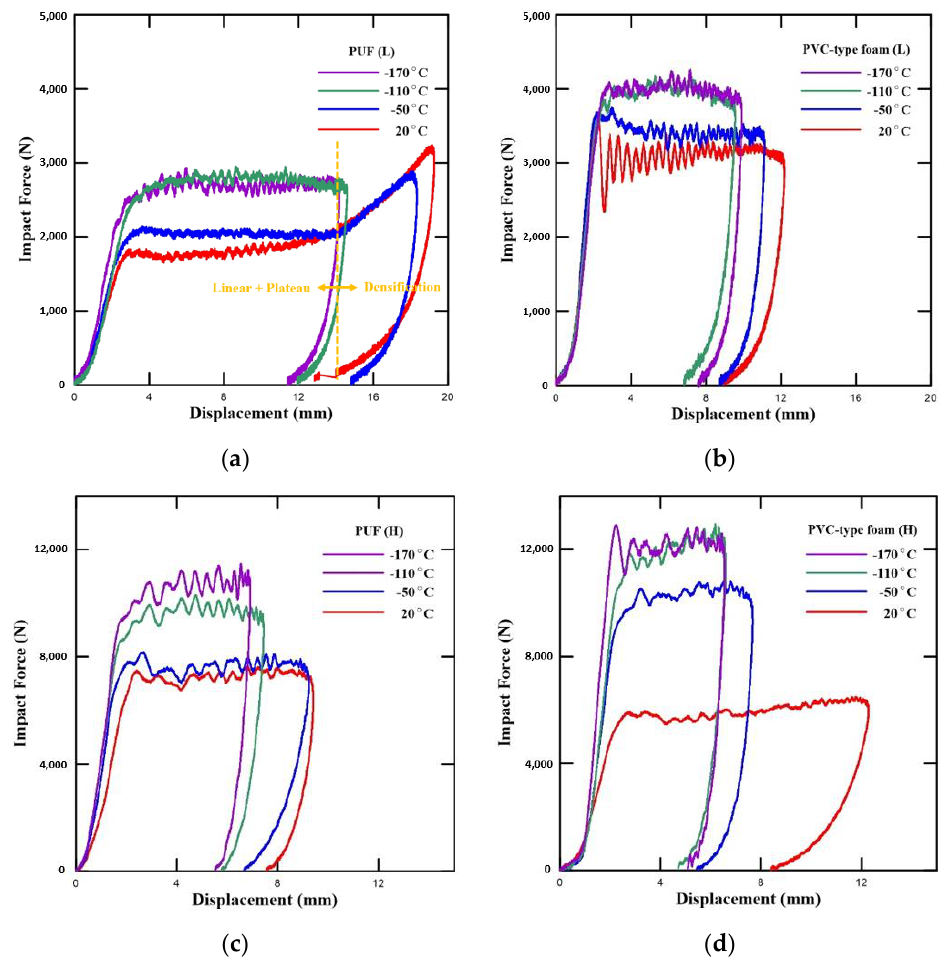
Figure 14. Force – displacement curves at 30 J ( a , b ) and 60 J ( c , d ) based on temperature: ( a ) neat PUF (L), ( b ) PVC-type foam (L), ( c ) Neat PUF (H), ( d ) PVC-type foam